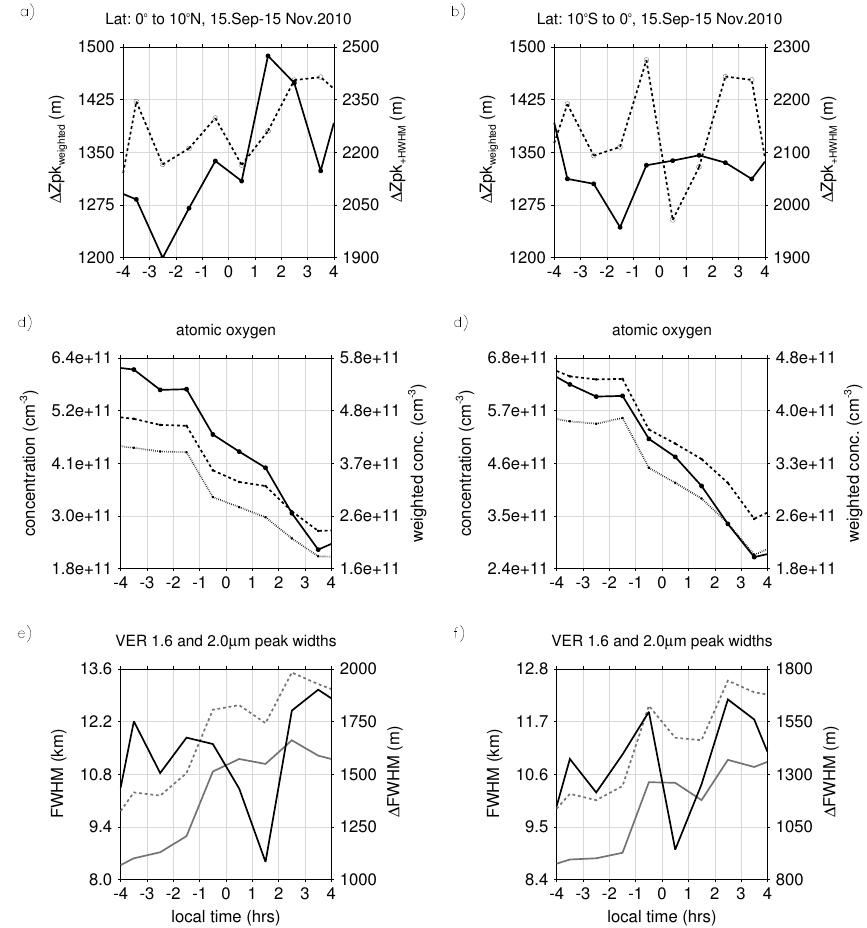
Figure 11. Diurnal variability according to SABER OH observations. (a–b) Relative vertical shifts between VER(1.6µm) and VER(2.0µm) Fig. 11: Diurnal variability according to SABER OH observations. Panel (a-b): relative vertical profiles in analogy with Fig. 7. (c–d) O concentrations at 90km level (left axis, solid line) and weighted with VER(1.6µm) and VER(2.0µm) OH peak shifts between VER( 1 . 6 µ m) and VER( 2 . 0 µ m) profiles in analogy with Fig. 7. Panel (c- (right axis, dotted and dashed line). (e–f) FWHM of VER(1.6µm) profile (grey dashed line), FWHM of VER(2.0µm) profile (grey solid line) and the difference 1 FWHM between both FWHM values (black solid d): O concentrations at 90 km level (left axis, solid line) and weighted with VER( 1 . 6 µ m) and VER( 2 . 0 µ m) (right axis, dotted and dashed line). Panel (e-f): FWHM of VER( 1 . 6 µ m ) profile (grey dashed line), FWHM of VER( 2 . 0 µ m ) profile (grey solid line) and the difference ∆ FWHM between both FWHM values (black solid line).